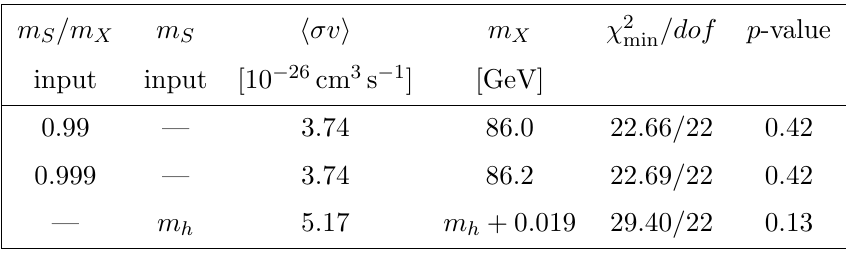
Table 1 . Values of the best (cid:12)ts to the GC gamma-ray excess spectrum for three values of m S =m X = 0 : 99 ; 0 : 999, and m S = m h (=125.18 GeV). The corresponding p -value of (cid:31) 2 degrees of freedom. Here (cid:26) (cid:12) = 0.4 GeV/cm 3 and (cid:13) = 1 : 2 are used as the canonical